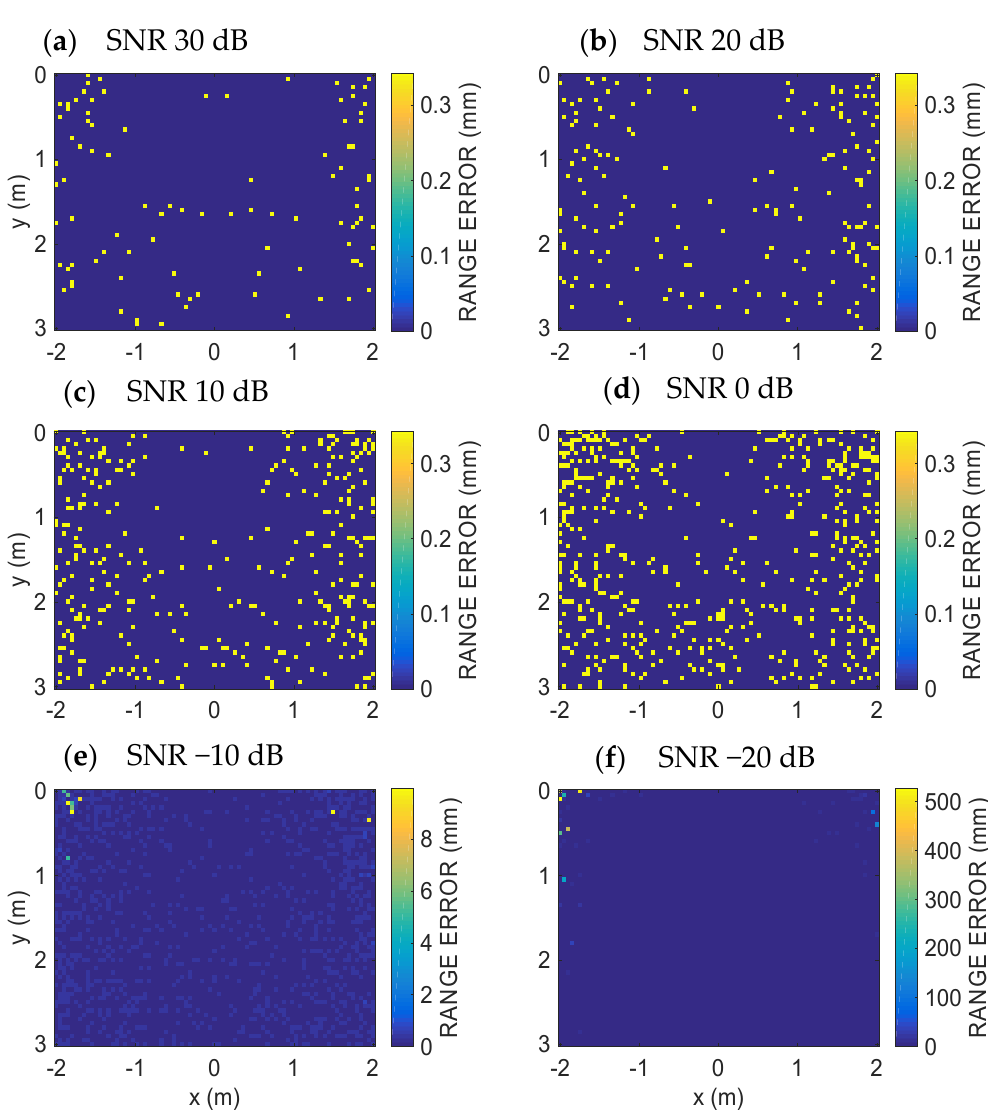
Figure 3. Numerical results at different SNR levels using a linear chirp 30–50 kHz. A linearized air absorption around 40 kHz has been assumed. Spatial error distribution along the section A of Figure 1: ( a ) SNR = 30 dB, ( b ) SNR = 20 dB, ( c ) SNR = 10 dB, ( d) SNR = 0 dB, ( e ) SNR = -10 dB, ( f ) SNR = -20 dB. Note the color bar error different ranges. For decreasing SNR from 30 dB down to 0 dB, the error is equal or less than 0.343 mm that is the spatial quantum. For lower SNR error rapidly increases up to more than 500 mm.